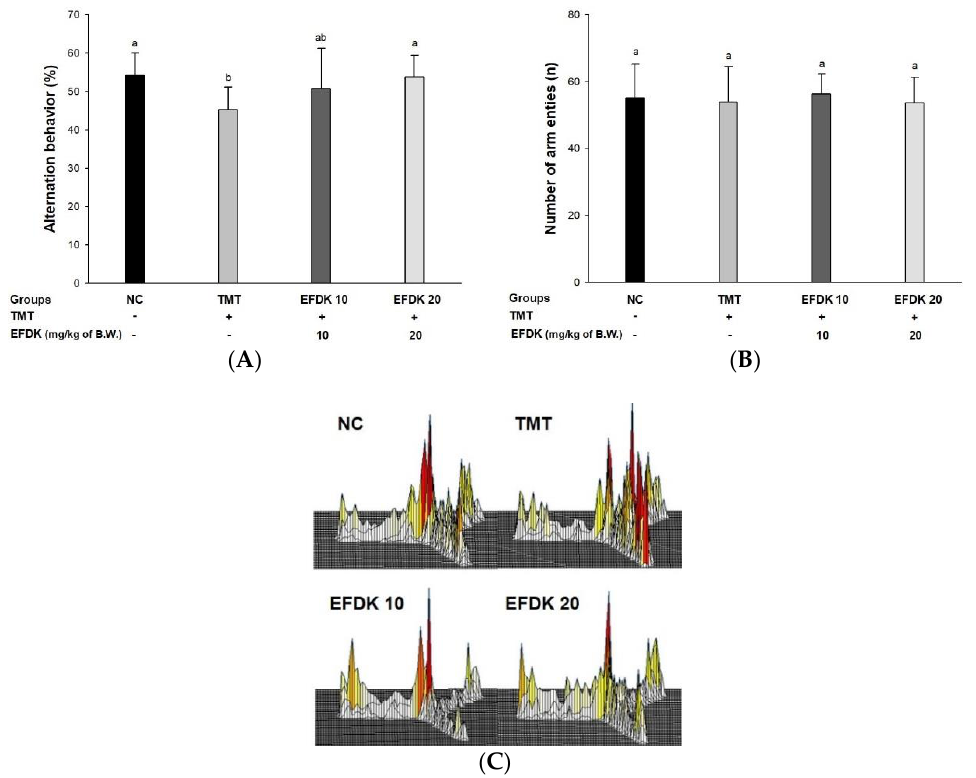
Figure 2. Protective effect of ethyl acetate fraction from persimmon (EFDK) on Y-maze test in TMT-induced mice. ( A ) Spontaneous alternation behavior; ( B ) number of arm entries; ( C ) 3D moving routes. Results shown are mean ± SD ( n = 8). Data were statistically represented at p < 0.05, and different small alphabets mean statistical significance.